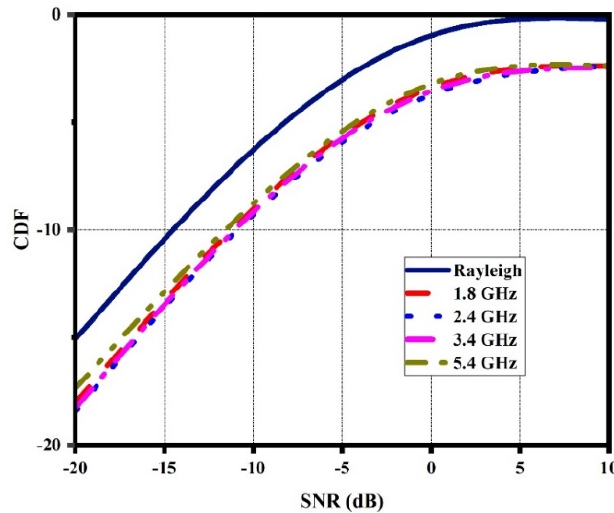
Figure 13. CDF of the DS MIMO antenna.